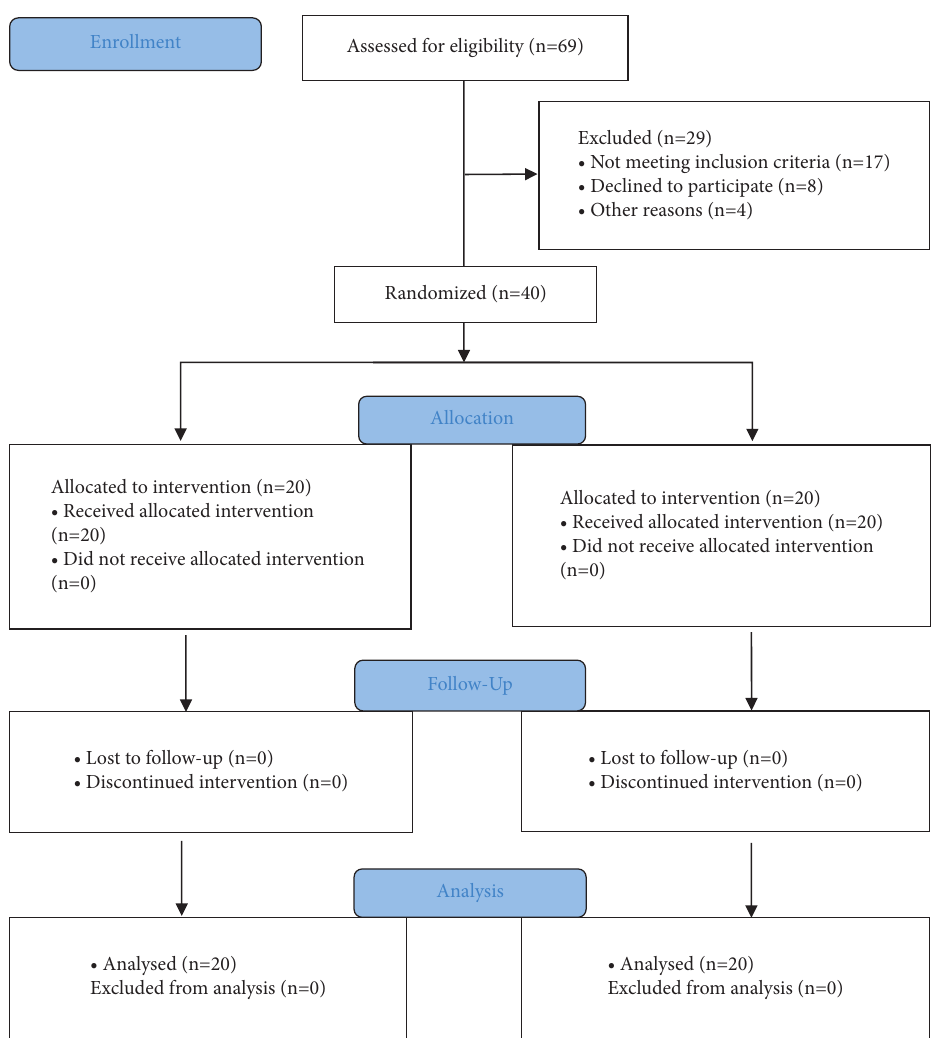
Figure 2: A CONSORT flow diagram depicting enrollment, group allocation, follow-up, and analysis of the study